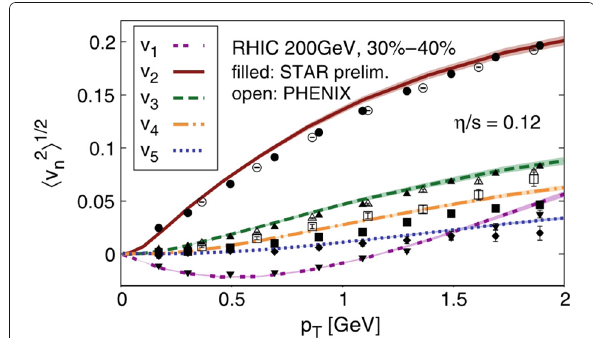
Fig. 8 Root-mean-square anisotropic flow coefficients (cid:5) v 2 n (cid:6) 1 / 2 as a function of the transverse momentum in mid-central Au+Au √ s NN = 200 GeV. Curves show hydrodynamic model collisions at calculations [47] assuming the shear viscosity η/ s = 0.12. Experimental data are from PHENIX [48] and STAR [49]